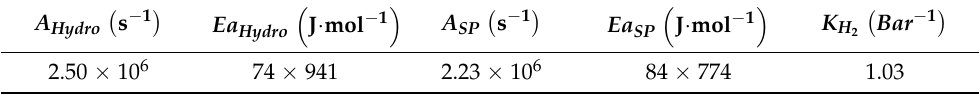
Table 10. Initial parameters used for the parameters estimation of the extrapolated Model 3. (cid:0) A Hydro s − 1